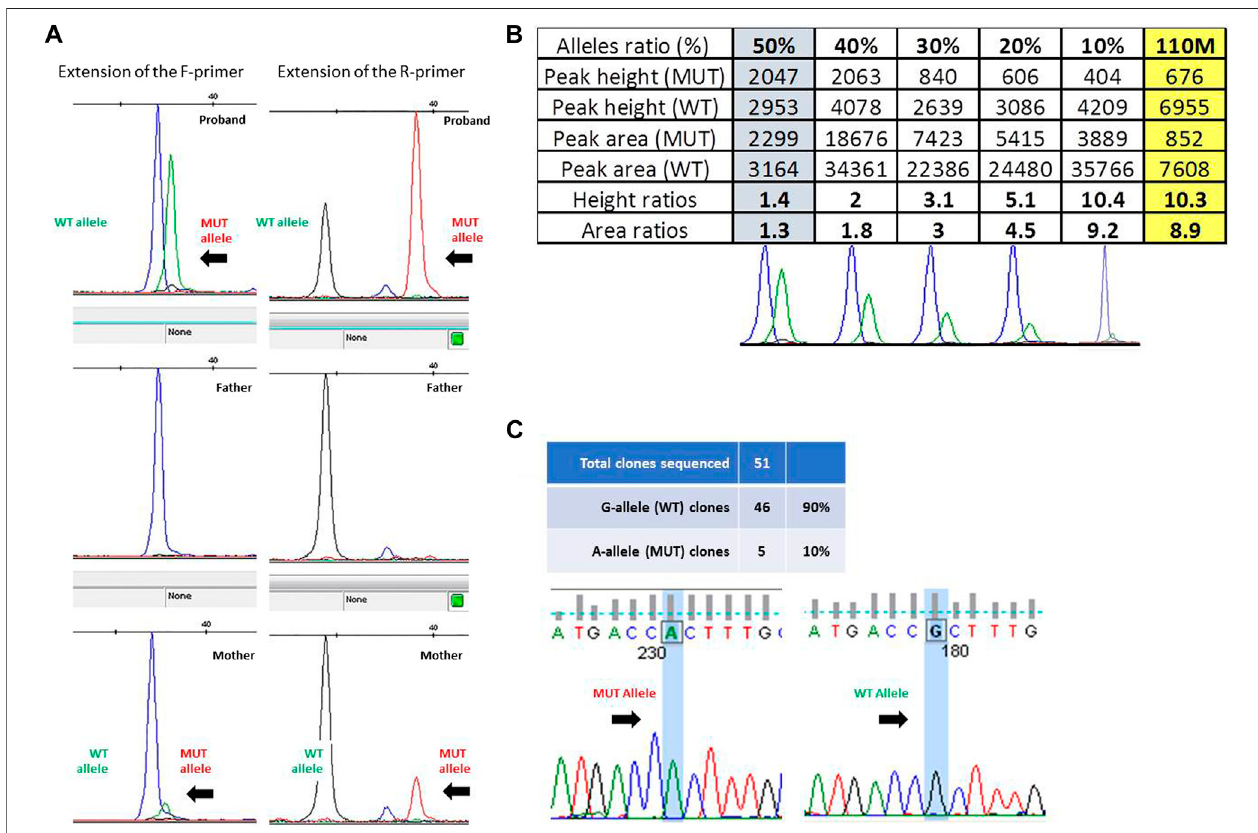
FIGURE2|(A) Fluorescencepeakofthelabelednucleotidesignalinsertedatthemutationsite,obtainedwithforward(F)andreverse(R)primersintrioID#110. (B) Peak height and area ratios obtained from ID#110M DNA sample (last yellow column) with bottom reference curves constructed using DNA mixtures containing known fractions ofthetwo alleles,i.e., 50%, 40%,30%,20%, and 10%from left toright. Given thatresults from both strands werevery consistent, tooptimize the fi gure and to avoidredundantinformation,onlydataobtainedfromthe “ F ” primerareultimatelyreportedhere. (C) Electropherogram ofthesequencesobtainedfromcoloniesof Escherichia coli with wild-type and mutated alleles and ratio between the number of colonies obtained.